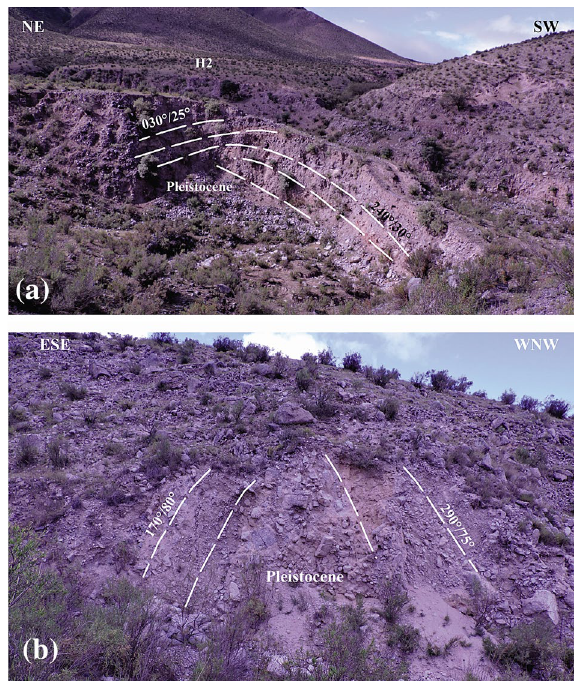
Fig. 14 View of a dextral transcurrent fault, with a vertical displace‑ ment component, affecting an outcrop of Lomitas Pegadas Forma‑ tion of Pleistocene age. On the surface of the ground you can see the falt scar. At the bottom there is a terrace on the left bank of the stream, made up of H2 accumulations. The fault gap is visible in the stream bed. The hammer serves as a